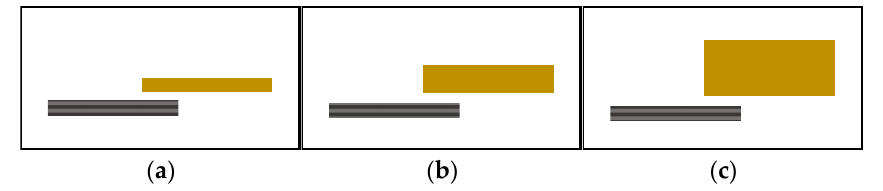
Figure 4. Single-lap welded joints for LW ( a ) welding of PEI 1 mm thick on CF/PEEK, ( b ) welding of PEI 2 mm thick on CF/PEEK and ( c ) welding of PEI 4 mm thick on CF/PEEK (yellow bars are PEI, grey bars for CF/PEEK).